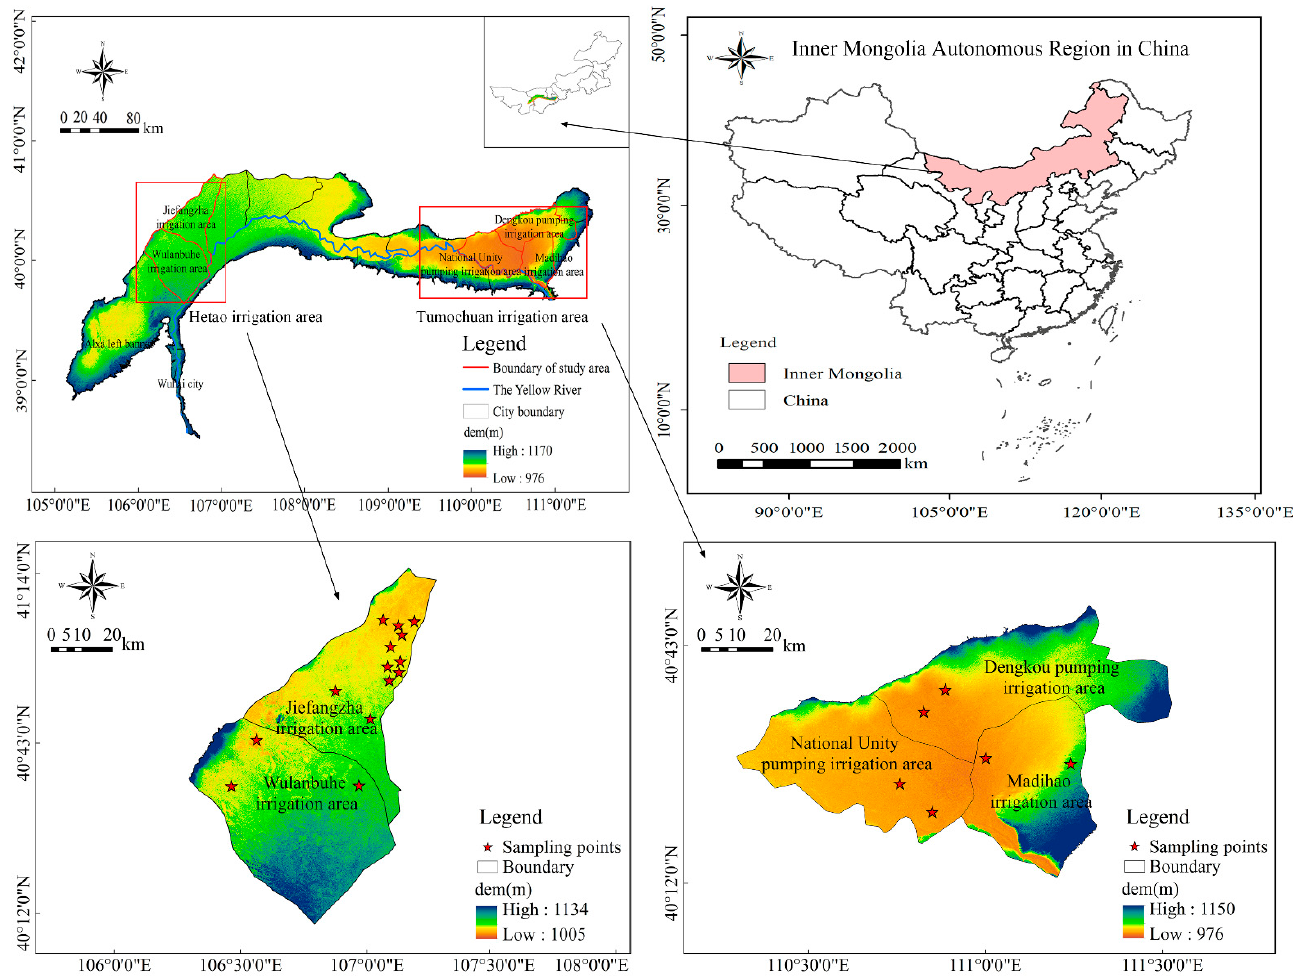
Figure 1. The Yellow River irrigation area in Inner Mongolia and distribution of sampling points.